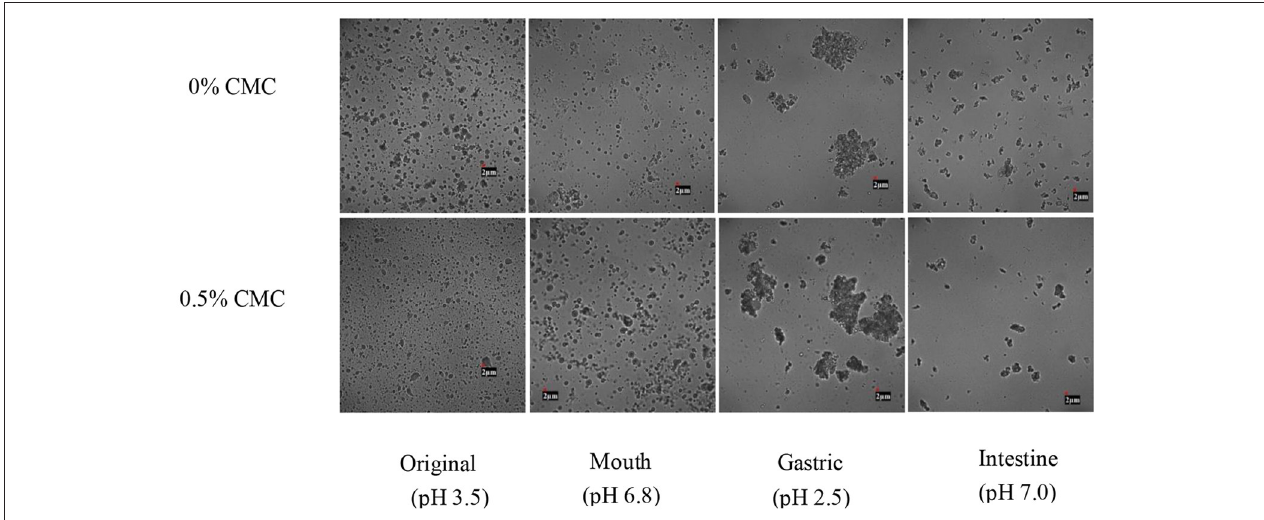
FIGURE 7 | The microstructures of different stages of SPI-stabilized rice bran oil emulsions with 0.5 wt% CMC after passing through an in-vitro digestion model (original, oral, gastric, and intestinal phases).